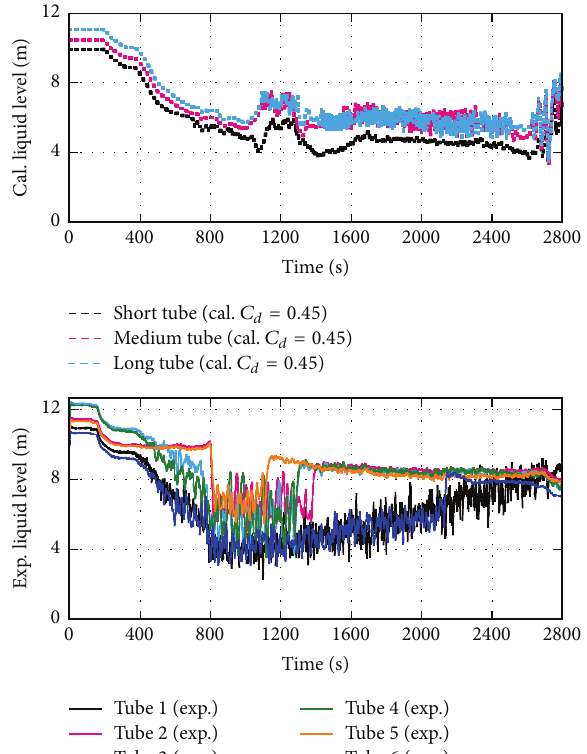
Figure 22: LSTF and RELAP5 results for SG U-tube upflow side collapsed liquid level in loop-A in case of no release of dissolved